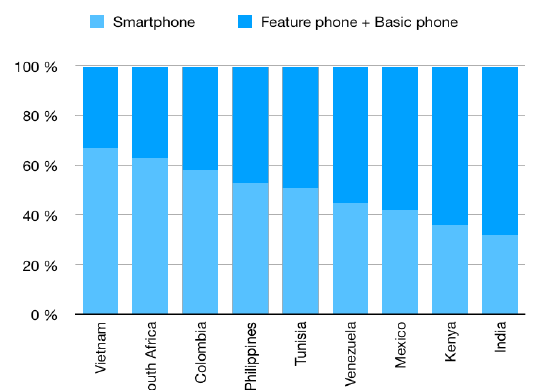
Figure 10. A percent comparison of mobile phone ownership in some developing